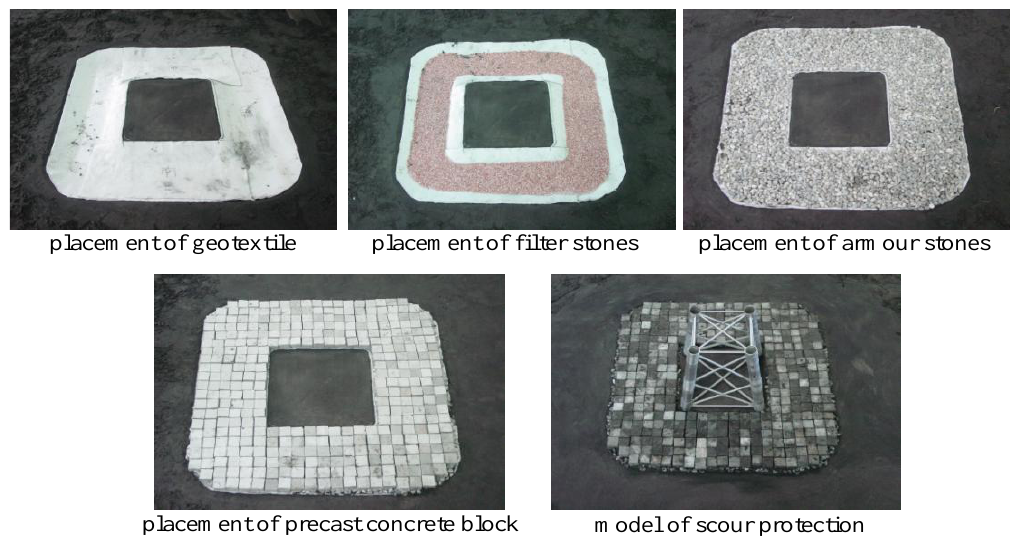
Figure 6. The experimental setup of the hard scour protection for the jacket-type